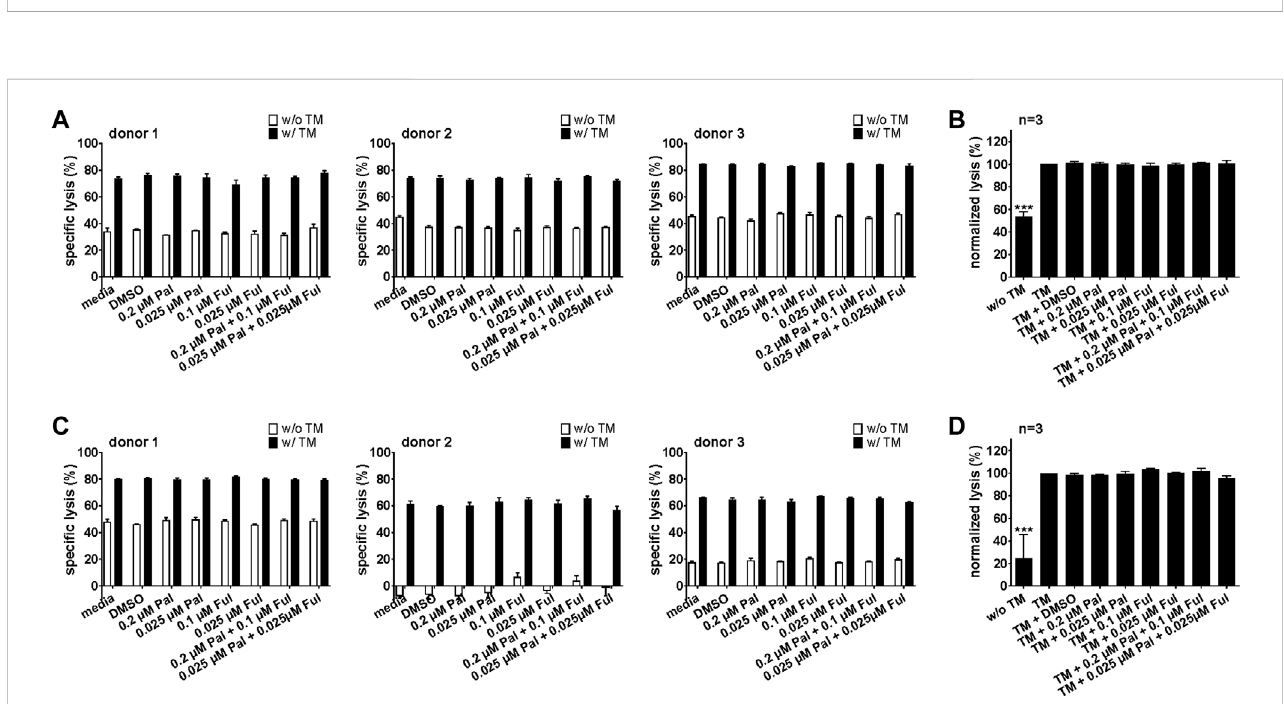
FIGURE 8 Effect ofpalbocicliband fulvestrant on UniCAR Tcell-mediated tumorcell killing. UniCAR Tcells and (A,B) LNCaP-PSCALuc+ or (C,D) PC3-PSCA/PSMA Luc+ cells were incubated with or without 30 nM of PSCA TM in the presence or absence of palbociclib and/or fulvestrant. After 8 h, tumor cell killing was calculated based on a luminescence-based killing assay. (A,C) Each diagram shows mean speci fi c lysis ± SEM of triplicates for one T cell donor. (B,D) Graphs summarize relative tumor lysis ± SEM of three different T cell donors. Speci fi c lysis in the presence of UniCAR T cells and TM ( “ TM ” ) were equalized to 100%. (*** p ≤ 0.001 compared to control sample “ TM ” ; One-way ANOVA with posthoc Dunnett multiple comparison